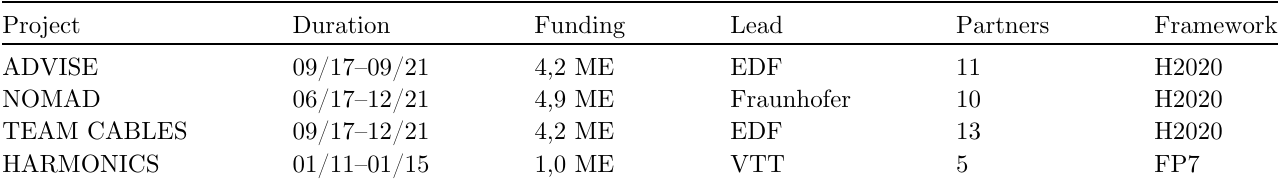
Table 1. Key fi gures for concerned projects.